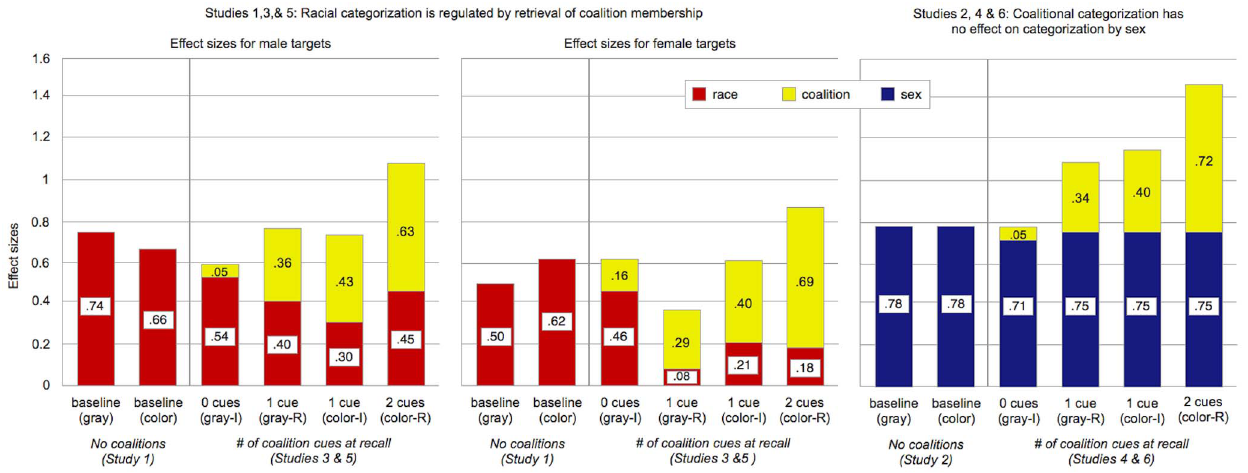
Figure 7. Categorization by coalition, race, and sex across six studies. Effect sizes for coalition (yellow bars) follow the same pattern across conditions. R and I refer to conditions in which the sentences at recall were coalition-relevant vs. coalition-irrelevant. When the recall context contains at least one cue that coalition-membership is relevant—either verbal (gray-R) or visual (color-I), racial categorization is down-regulated as much as when there are two cues (color-R). Gender categorization is not affected at all by coalitional manipulations. The different heights of the stacked bars show that categorization is not zero-sum: Retrieval of one category can be up-regulated without causing any decrease in retrieval of the crossed category.